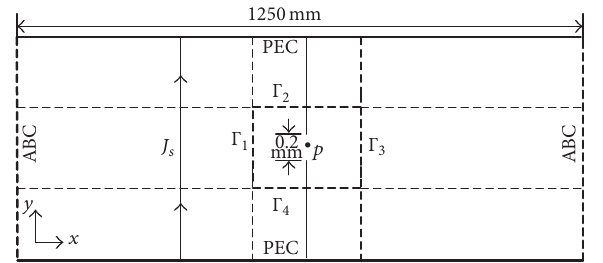
Figure 2: Parallel plate waveguide with the PEC slot of 0.2 mm [4].